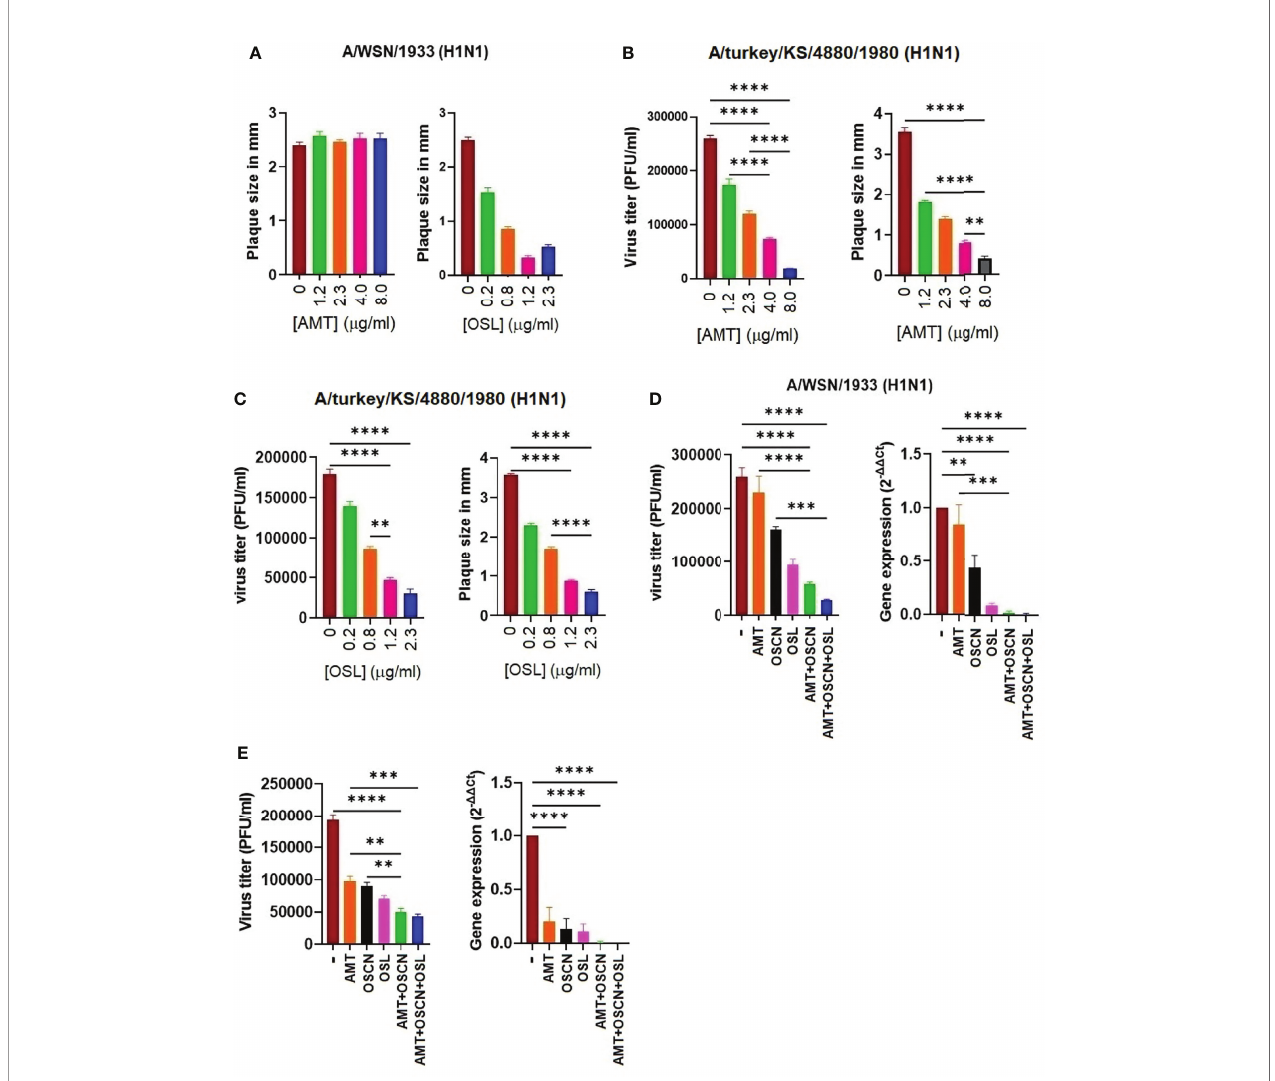
FIGURE 6 | A triple combination therapy including AMT, OSCN − , and OSL, is superior to dual and single drug regimens against amantadine-sensitive and amantadine-resistant in fl uenza A strains in vitro . Con fl uent MDCK cell monolayers in 6-well plates were infected with 100 MOI of the (A) A/turkey/Kansas/4880/ 1980 (H1N1) (AMT-susceptible strain) or (B, C) the A/WSN/1933 (H1N1) (AMT-resistant) IAV strains. Cells were incubated with overlay media containing the indicated antiviral drugs and their combinations. The plaque numbers or the average plaque sizes measured in diameter were determined at 3 dpi. Mean ± SEM, three independent experiments. The ef fi cacy of the triple combination treatment consisting of OSCN − , AMT, and OSL on viral replication (plaque assays) and viral gene expression (qPCR) is shown for (D) the A/WSN/1933 (H1N1) and (E) A/turkey/Kansas/4880/1980 (H1N1) IAV strains. [AMT] = 15 m g/ml, [OSL] = 5 m g/ml. b -Actin was used as a housekeeping gene. Data are presented from three individual experiments (n = 3). One-way ANOVA and Tukey ’ s multiple comparisons tests. AMT, amantadine; IAV, in fl uenza A virus; OSCN − , hypothiocyanite; MOI, multiplicity of infection; OSL, oseltamivir; PFU, plaque-forming unit; MDCK, Madin – Darby canine kidney. **, p < 0.01; ***, p < 0.001; ****, p <